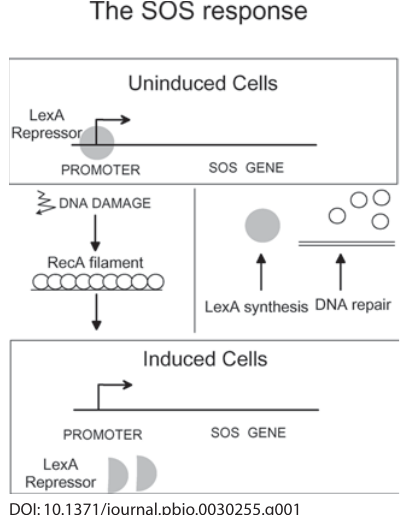
Figure 1. An Oscillatory Behavior for the SOS Response In non-induced growth conditions, the LexA repressor binds to SOS-controlled promoters, limiting or preventing their action. The basal level of expression of the genes that belong to the SOS regulon is variable. For example, in non-induced cells there are 7,500 molecules of RecA and undetectable amounts of Pol V. Upon DNA damage, RecA fi laments formed at sites of damage activate the autocleavage of the LexA repressor, allowing SOS gene expression. SOS induction is reversed when damages are repaired. This is due to the disappearance of the RecA fi lament and allows the newly synthesized LexA molecules to bind SOS promoters. The recent work by Joel Stavans’ laboratory provides evidence that, after DNA damage, individual cells oscillate between an induced and a less-induced state, and that the level of DNA damage governs the number of high-induced phases rather than their amplitude and timing [11]. Grey circles, LexA; white circles,